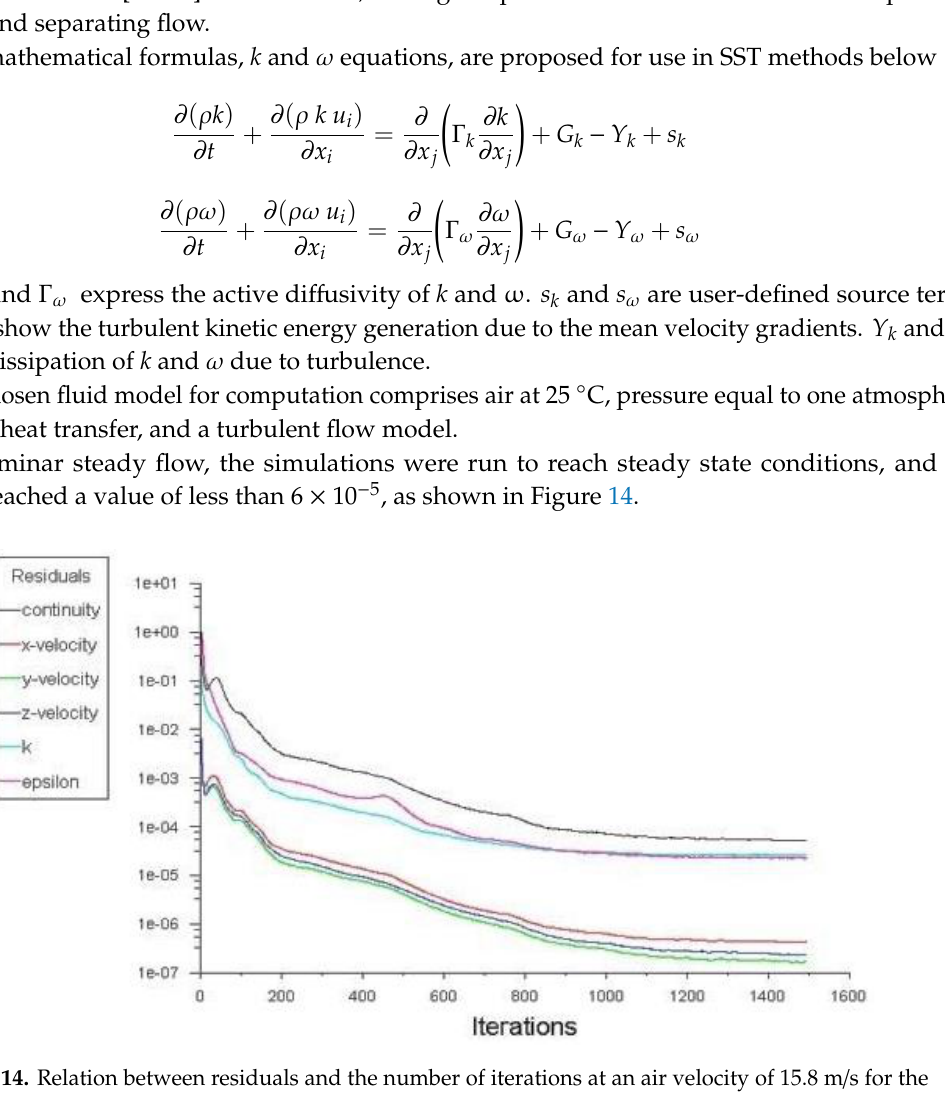
Figure 14. Relation between residuals and the number of iterations at an air velocity of 15.8 m/s for the IceWind turbine at θ = 90°.